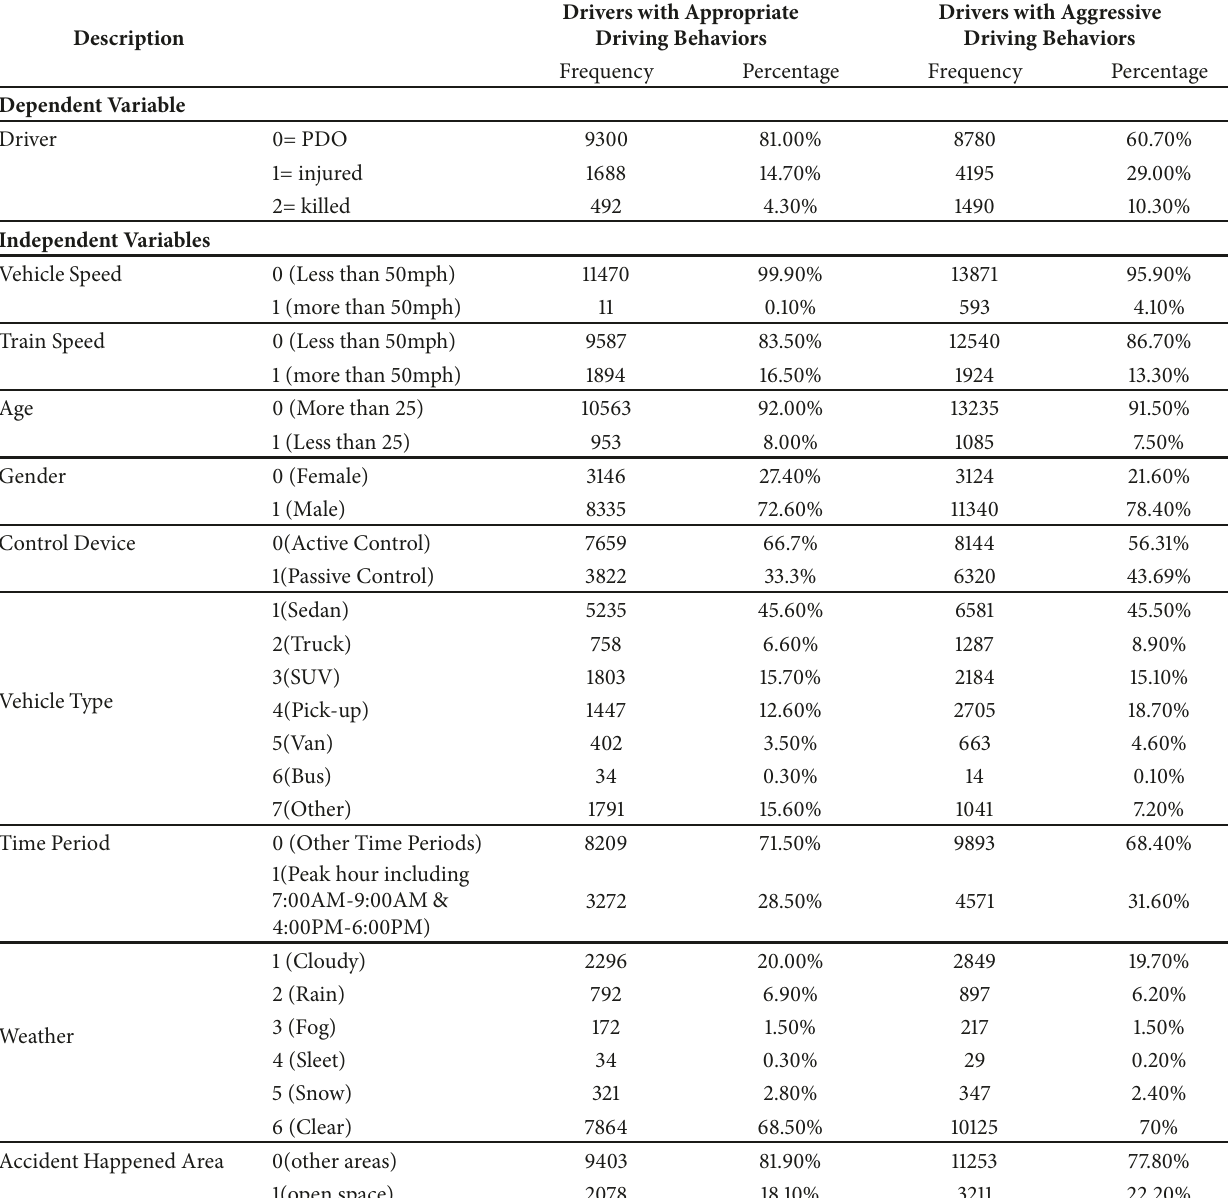
Table 1: Description of Highway-Rail Collision